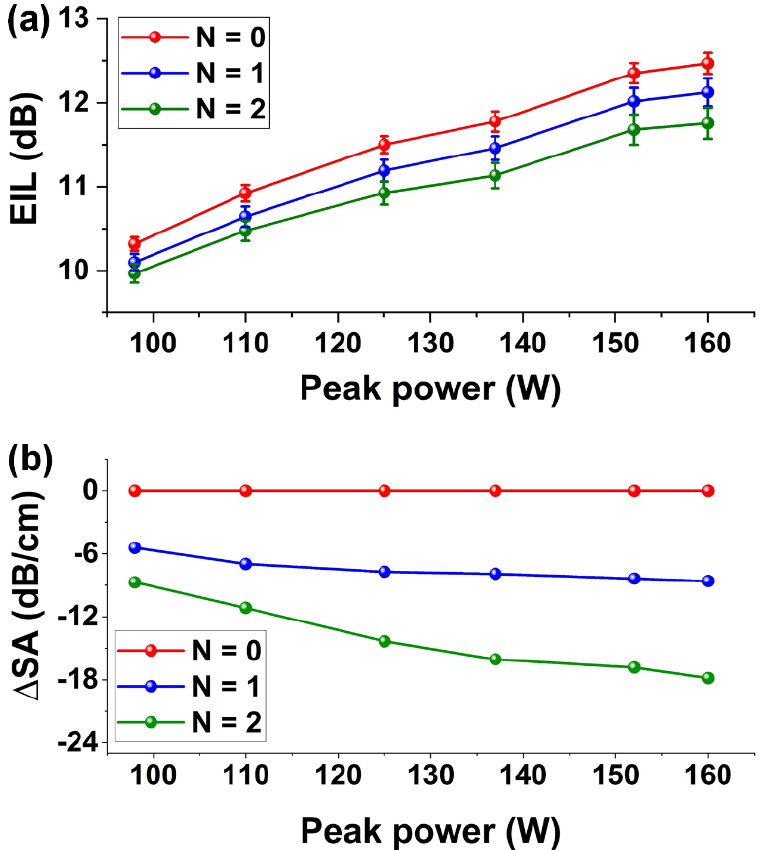
Figure 3. ( a ) Measured excess insertion loss ( EIL ) of GO-coated SOI nanowires versus input power of optical pulses. ( b ) Excess propagation loss induced by the S A (∆ SA ) versus peak power of input optical pulses. In ( a , b ), the results for uncoated ( N = 0) and hybrid SOI nanowires coated with one and two layers of GO ( N = 1, 2) are shown for comparison. The data points depict the average of measurements on three samples, and the error bars illustrate the variations among the different samples.